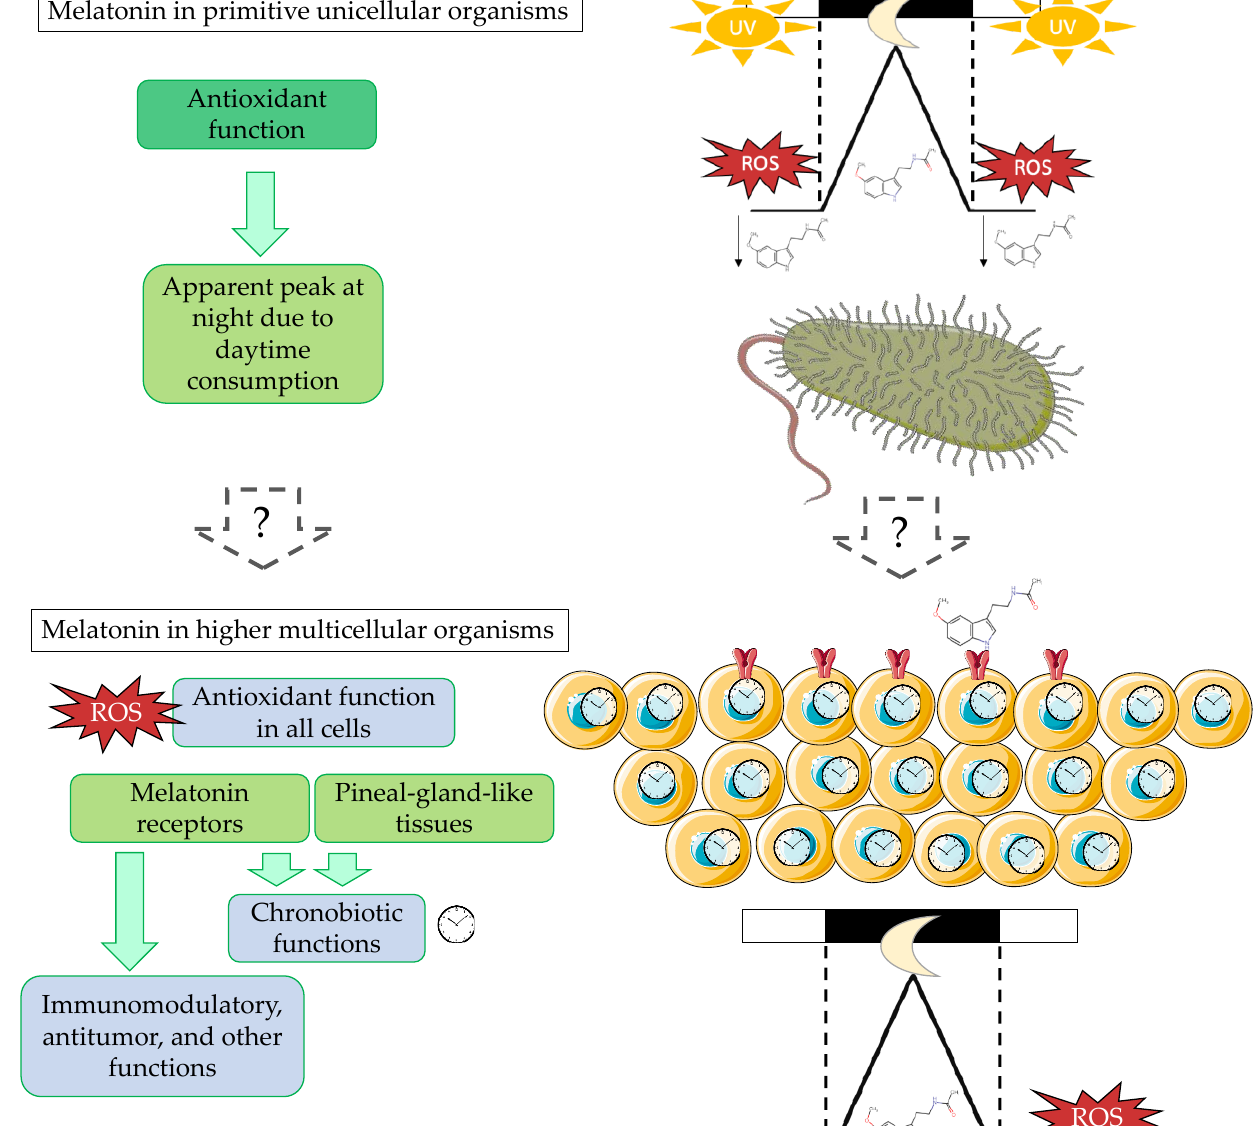
Figure 1. Melatonin’s biological functions throughout evolution. In primitive unicellular organisms ( upper panel ), its antioxidant primary function generated an apparent concentration peak at night. Subsequent events drove the appearance of melatonin receptors and pineal gland-like tissues ( lower panel ), permitting higher multicellular organisms to adopt melatonin as a chronobiotic (darkness) signal while maintaining local extrapineal melatonin production in most organs and tissues, exerting its antioxidant original function. Melatonin in multicellular organisms also presents a wide range of actions, such as immunomodulatory and antitumor, among others. This figure was built with SMART resources (Servier Medical Art) and licensed under a Creative Common Attribution 3.0 Generic License. See http://smart.servier.com/.